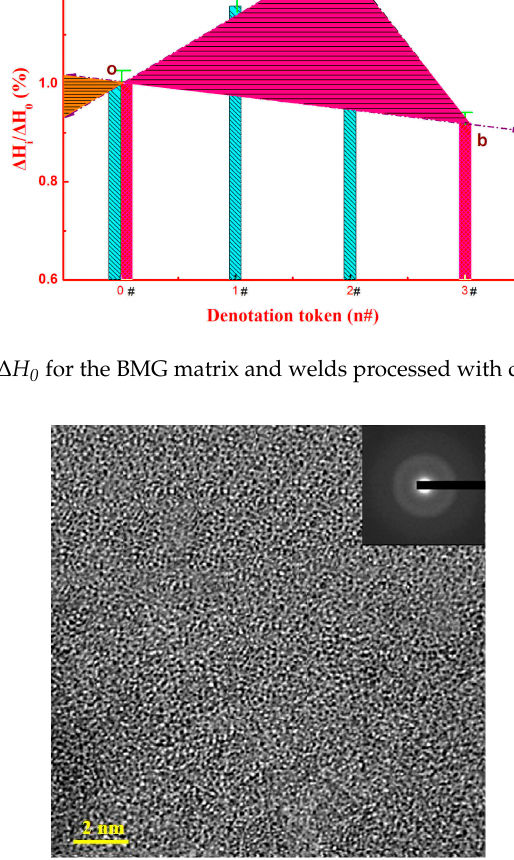
Figure 7. The bright field image and selected area diffraction pattern of the BMG matrix.